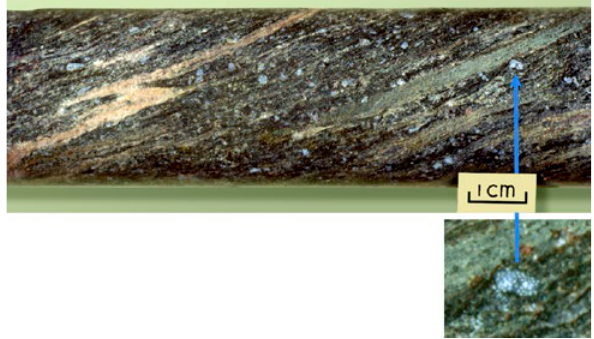
Figure 18. The accretionary origin of the small quartz ovoids in the Olive Wood re-liquefied sediment lens at Tennant Creek, NT, is cle- arly indicated by the many examples of the aggregation of sub-units of former polymeric silica. The enlargement shows this aggregation but most small accretions in this rock have crystallised to small round globules of quartz (From Elliston, 2017, p. 153).